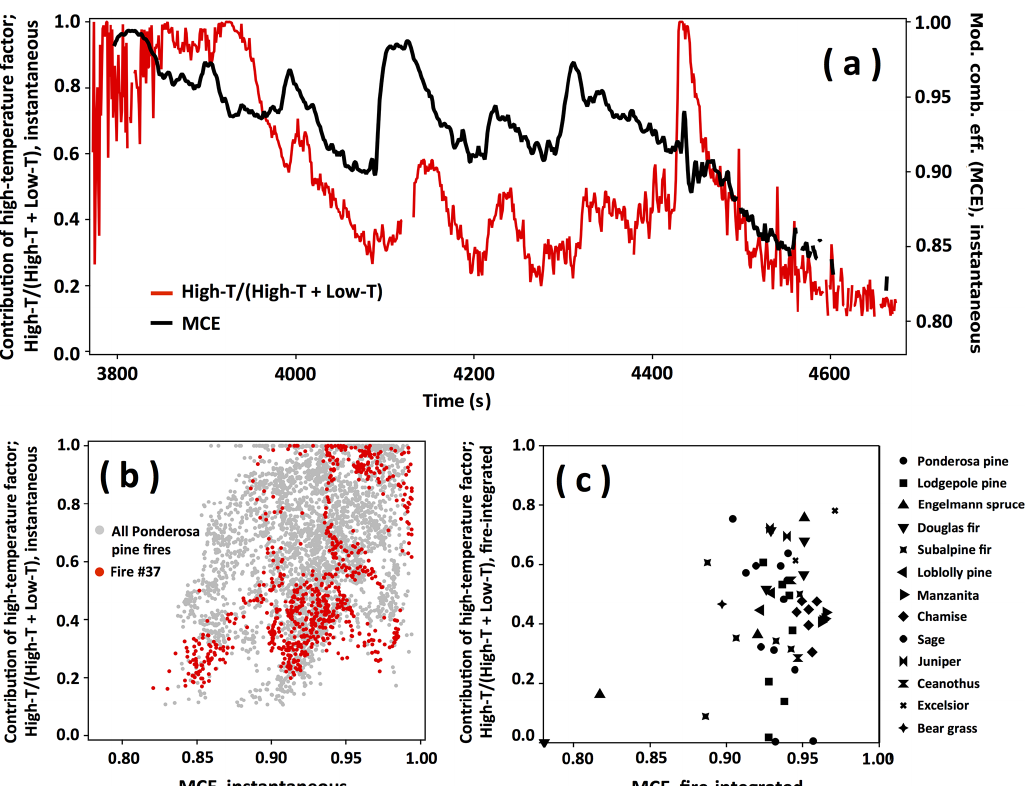
Figure 11. The comparison of contribution of high-temperature factor versus modified combustion efficiency (MCE). (a) Time series of Fire no. 37 (ponderosa pine realistic mixture). (b) Scatter plot of instantaneous high-temperature contribution versus MCE for all ponderosa pine fires. (c) Scatter plot of fire-integrated high-temperature contribution versus MCE for all fires. Contribution of high-temperature factor was calculated by (cid:54) VOC high- T /((cid:54) VOC high- T + (cid:54) VOC low- T ) instantaneously or on a fire-integrated basis. T =